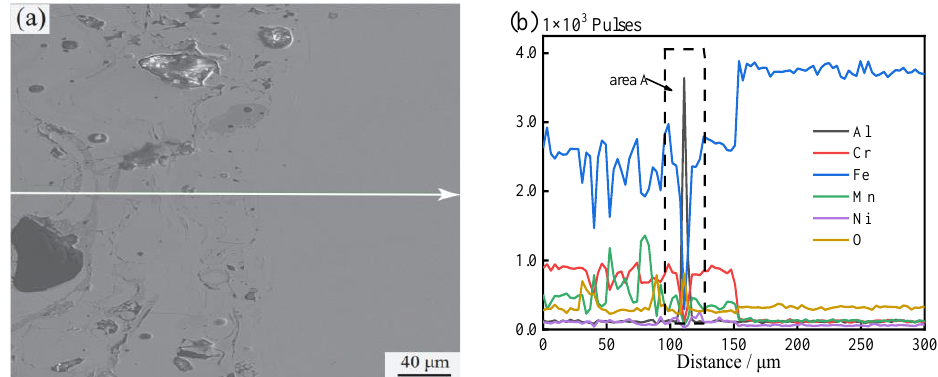
Figure 5. EDS line scan analyses of the interfaces between coating and substrate ( a ) SEM cross- sectional image; ( b ) Line scan profile for the coating-substrate interface.